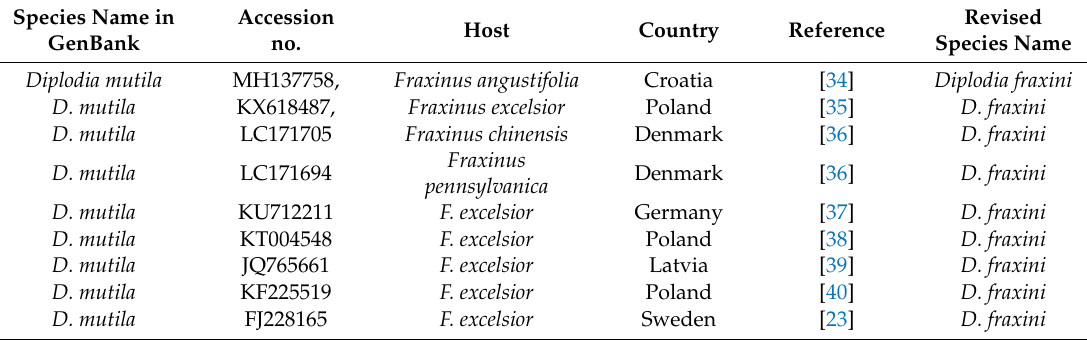
Table 3. Re-evaluation of ITS rDNA sequences erroneously associated with Diplodia mutila in